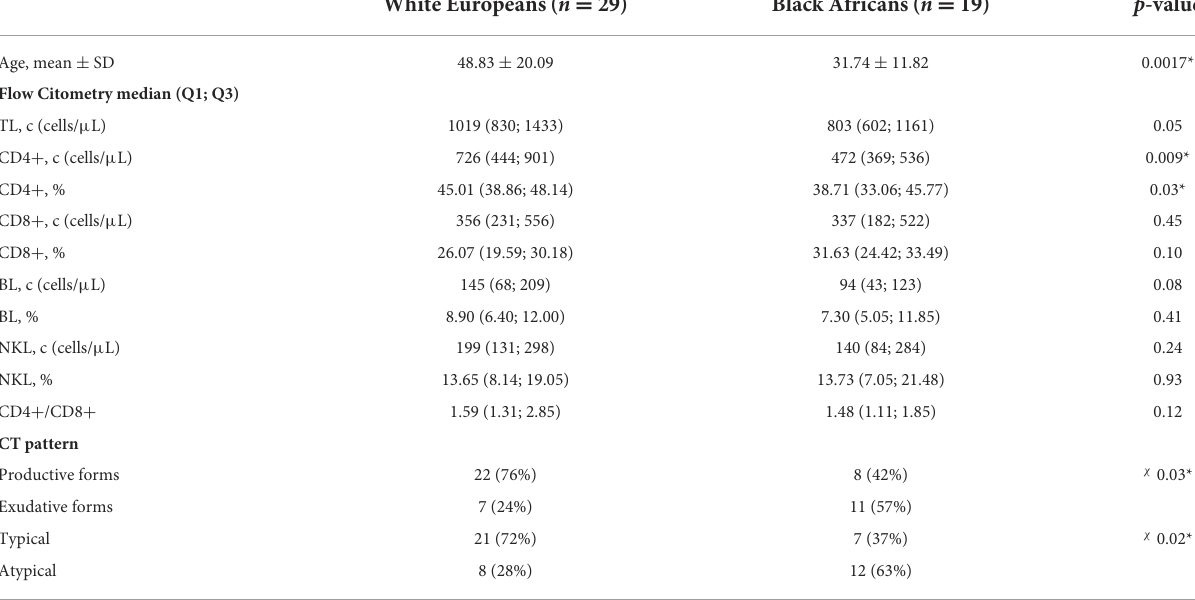
TABLE 4 Demographic characteristics, flow cytometry, and chest CT results in patients with TB according to their nationality (Europeans or Africans). White Europeans ( n = 29) Black Africans ( n =